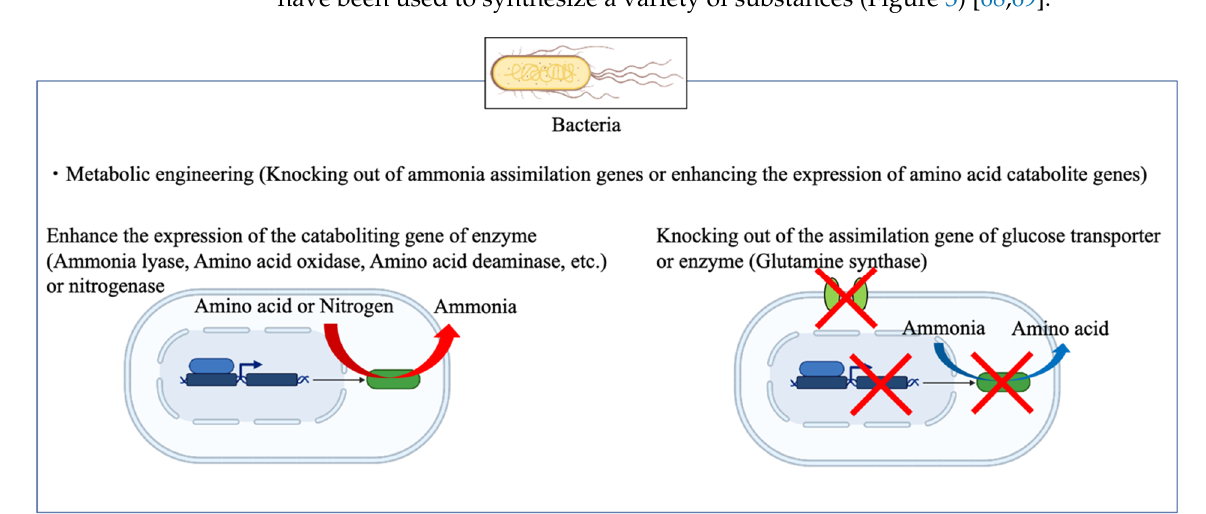
Figure 3. Ammonia production using engineered bacteria (created with Biorender.com).